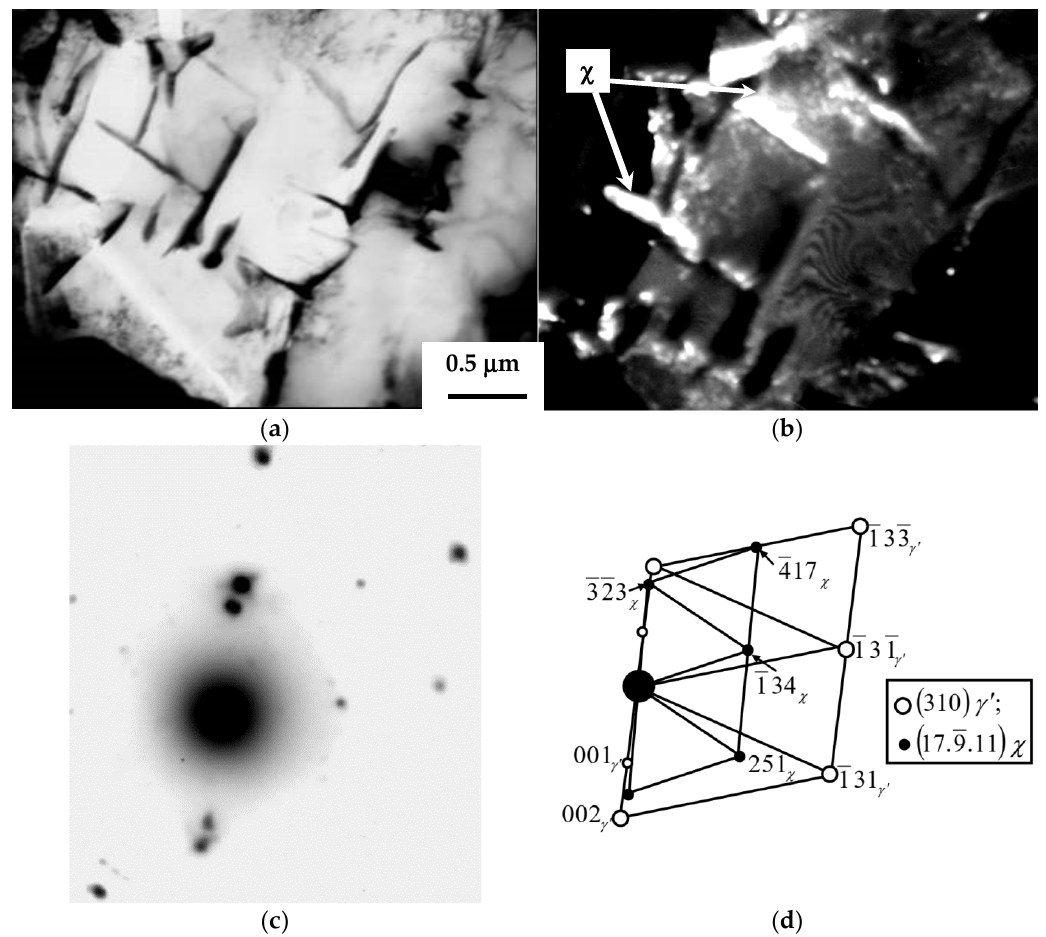
Figure 3. Electron microscopic image of the structural phase state “C” in the alloy after DC: ( a ) bright-field image; ( b ) dark-field image obtained in the reflection [323] χ ; ( c ) microdiffraction pattern; ( d ) its indicated scheme.